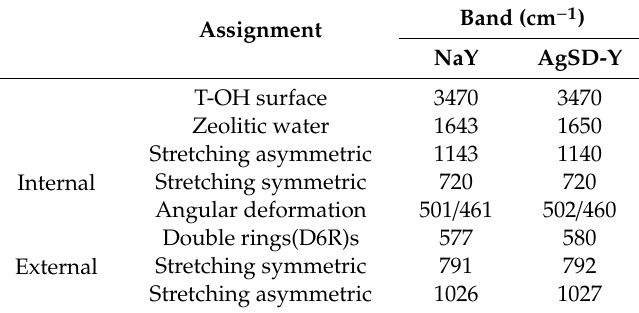
Figure 6. Spectrum of ( a ) NaY, AgSD-Y zeolite and ( b ) pure AgSD. Table 1. Vibrational bands obtained for NaY and AgSD-Y zeolite.